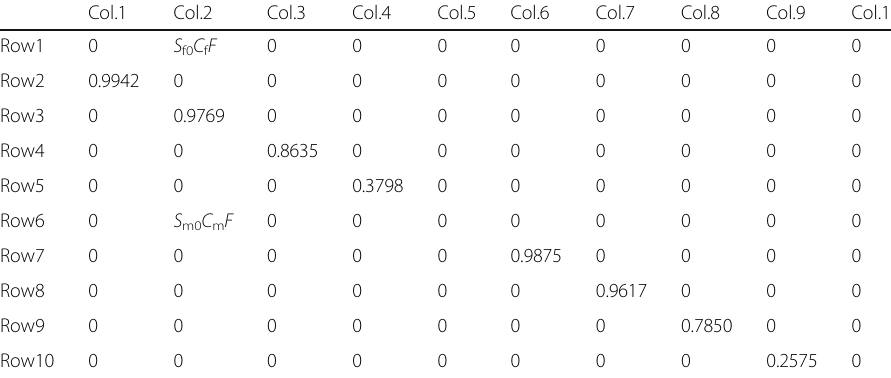
Table 7 The calibrated Q matrix for a stable population Col.1